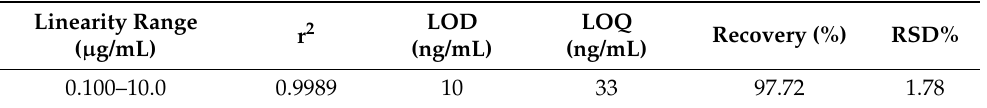
Table 1. Quality control parameters for the developed method for determining VD 3 content in saponified Penaeus sinensis by-products ( n =